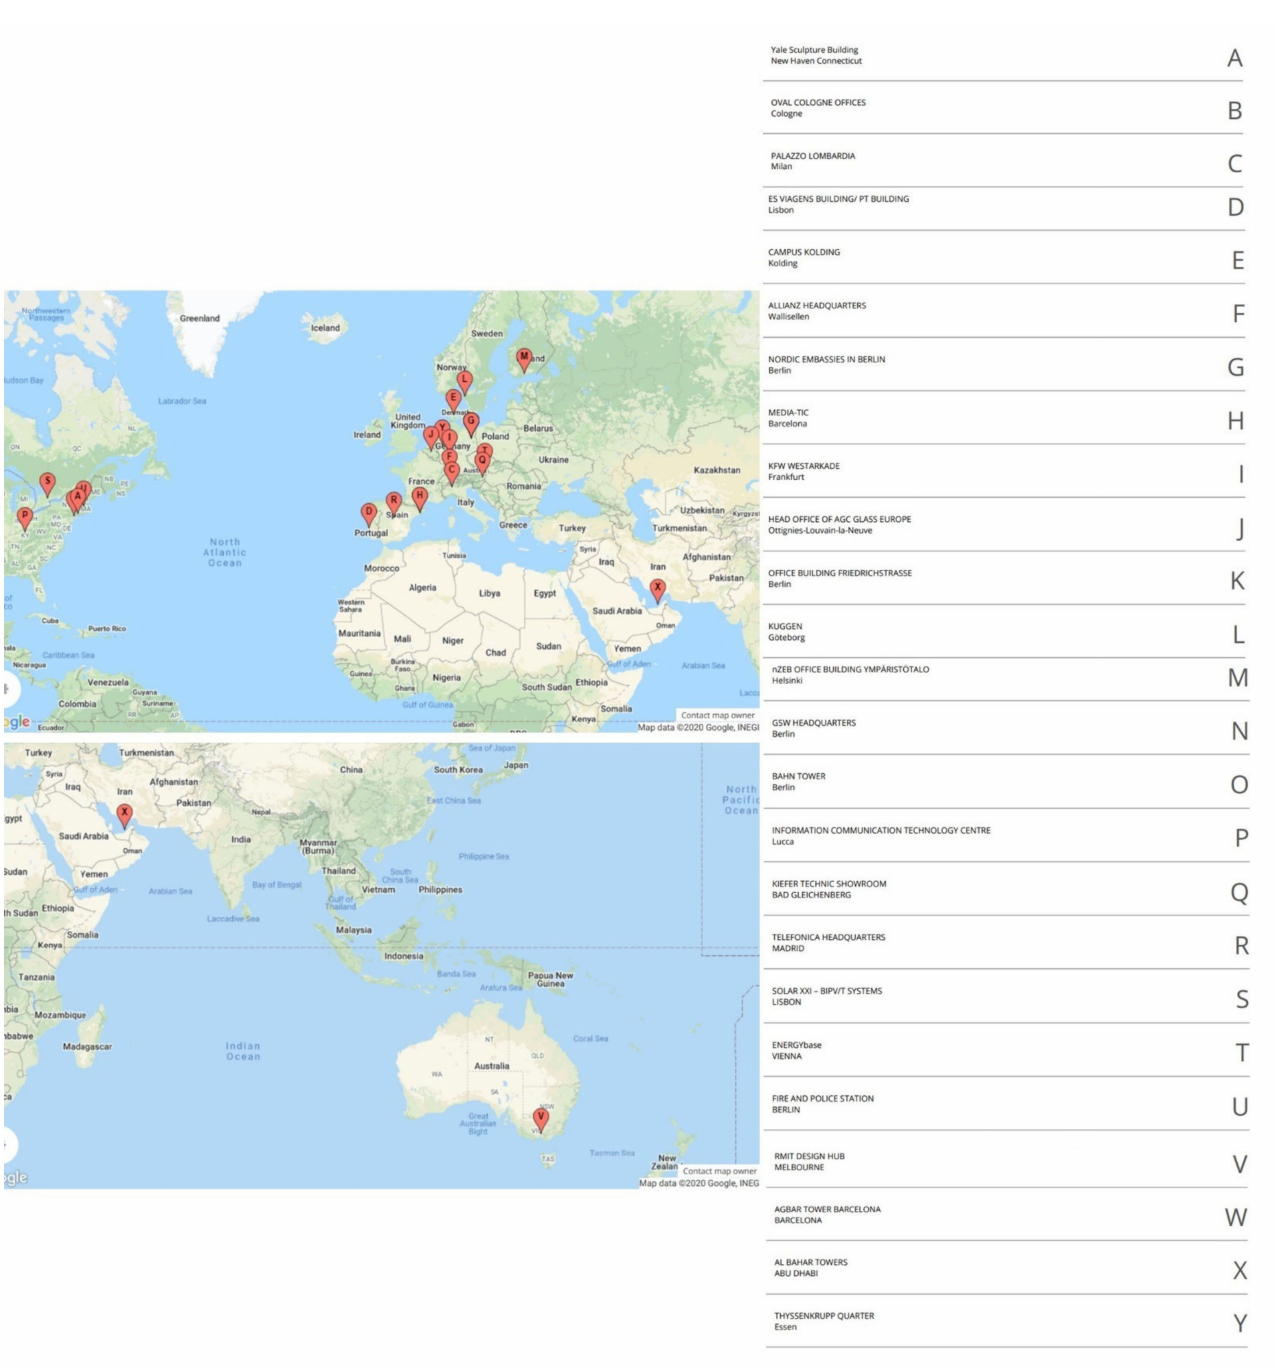
Figure 7. Location map of the CABS office buildings (retrieved from https://batchgeo.com/map/ cd08b547f0cb89143f81c38bfac2fc06 (Accessed on 16 December